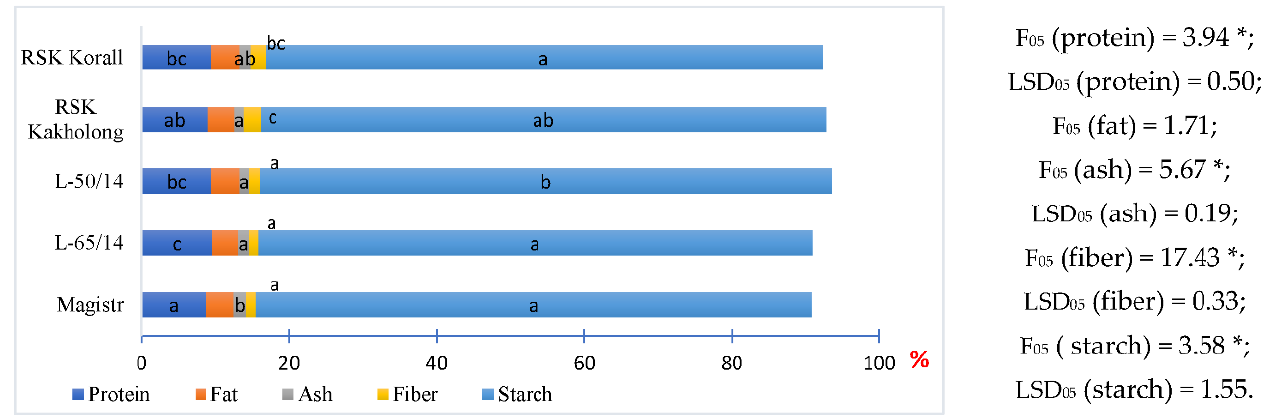
Figure 2. Biochemical composition of sorghum grain (average for 2021–2022), %. Note: * p ≤ 0.05. Different letters indicate values that differ significantly from each other in the column or the table by comparison with the Dunn’s test.